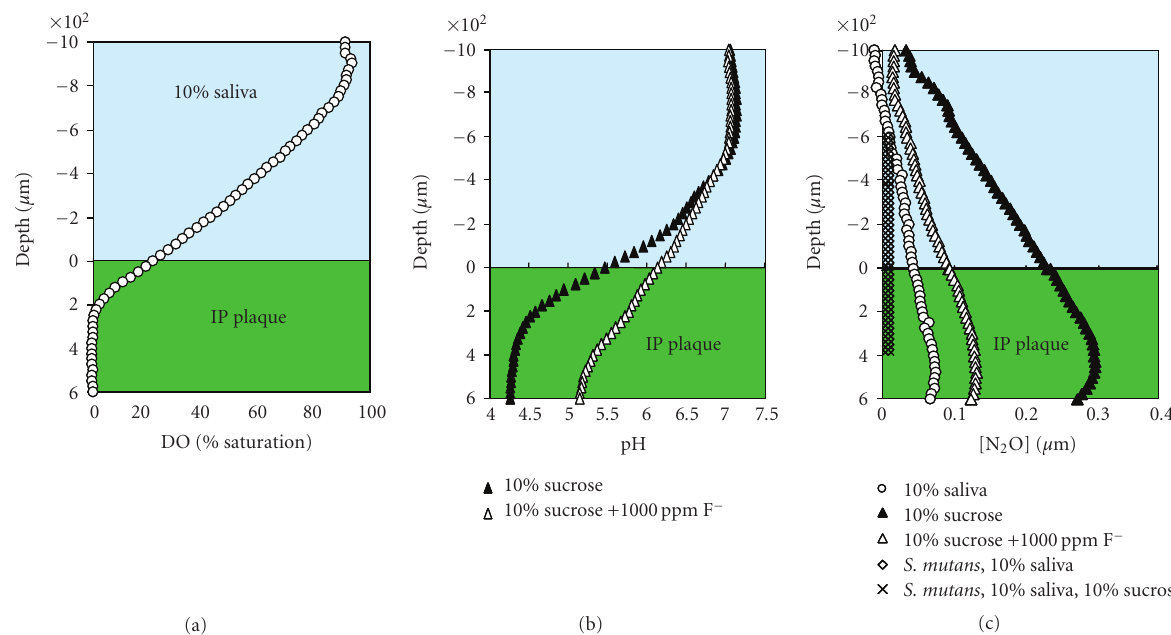
Figure 4: Metabolic activity in interproximal plaque. (a) In 10% saliva the plaque was anaerobic below a depth of 200 μ m. (b) The addition of 10% sucrose reduced the pH from neutral to 4.2 within the dental plaque biofilm. NaF increased the pH by approximately 1 unit suggesting that acid fermentation had been inhibited. (c) N 2 O production in the biofilm demonstrated that the interproximal plaque was denitrifying. Addition of sucrose stimulated denitrification while F suppressed